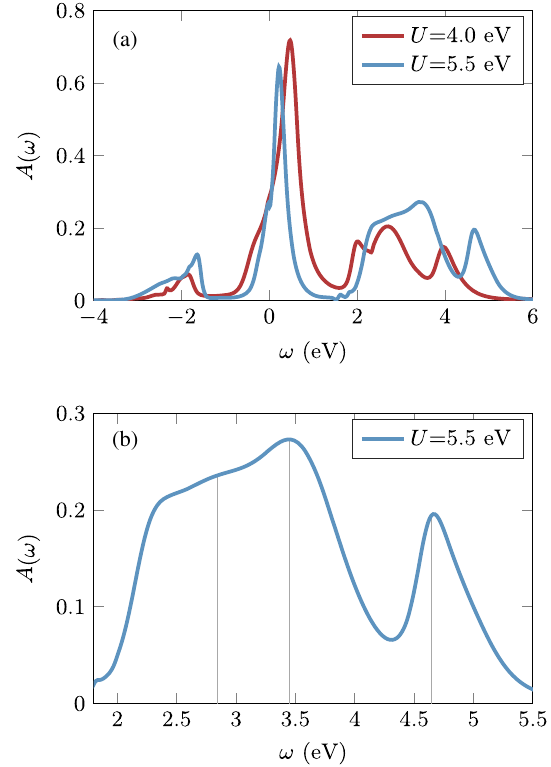
FIG. 9. (a) Increasing U results in a slimmer central peak and a shift of the upper Hubbard band. Also, the three-peak structure gets smeared out. (b) Close-up of the upper Hubbard band. As in Fig. 8, additional vertical lines are plotted at ω (position of the M 2 J and ω − J as a rough guide to middle peak) and at ω M þ M where the atomic peaks would be located. With the help of these lines, one can discern a three-peak structure again, but it is extended by a feature at the low energy side of the Hubbard